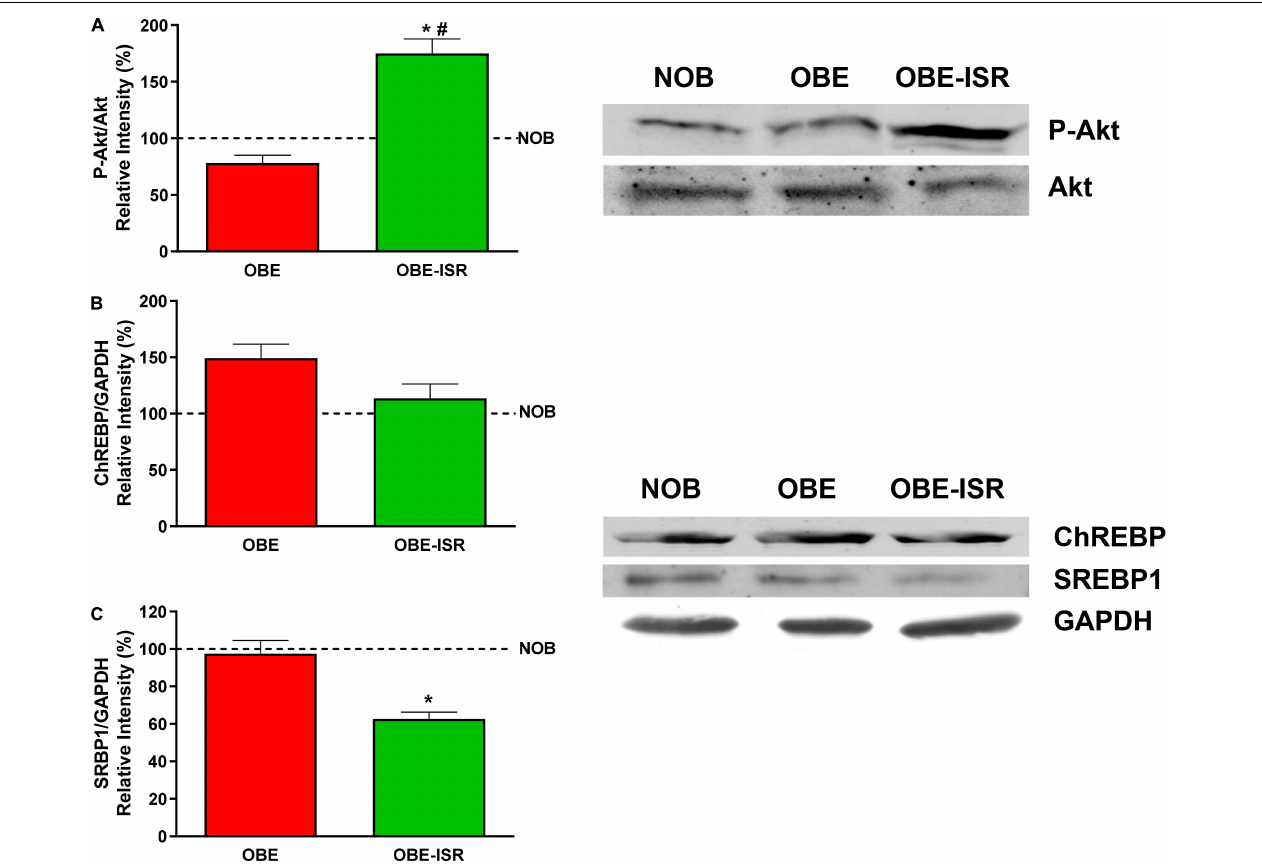
FIGURE 5 | Key signaling elements related to insulin sensitivity and lipid synthesis in the liver. (A) p-Akt. (B) ChREBP. (C) SRBP1. Rats were fed a normal rodent diet (NOB) or a high-fat diet (HFD) formulated with rapidly (OBE) or with slowly digestible carbohydrates (OBE-ISR). Data expressed as mean ± SEM. *Significant difference with NOB group, p < 0.05. #Significant difference with OBE group, p <